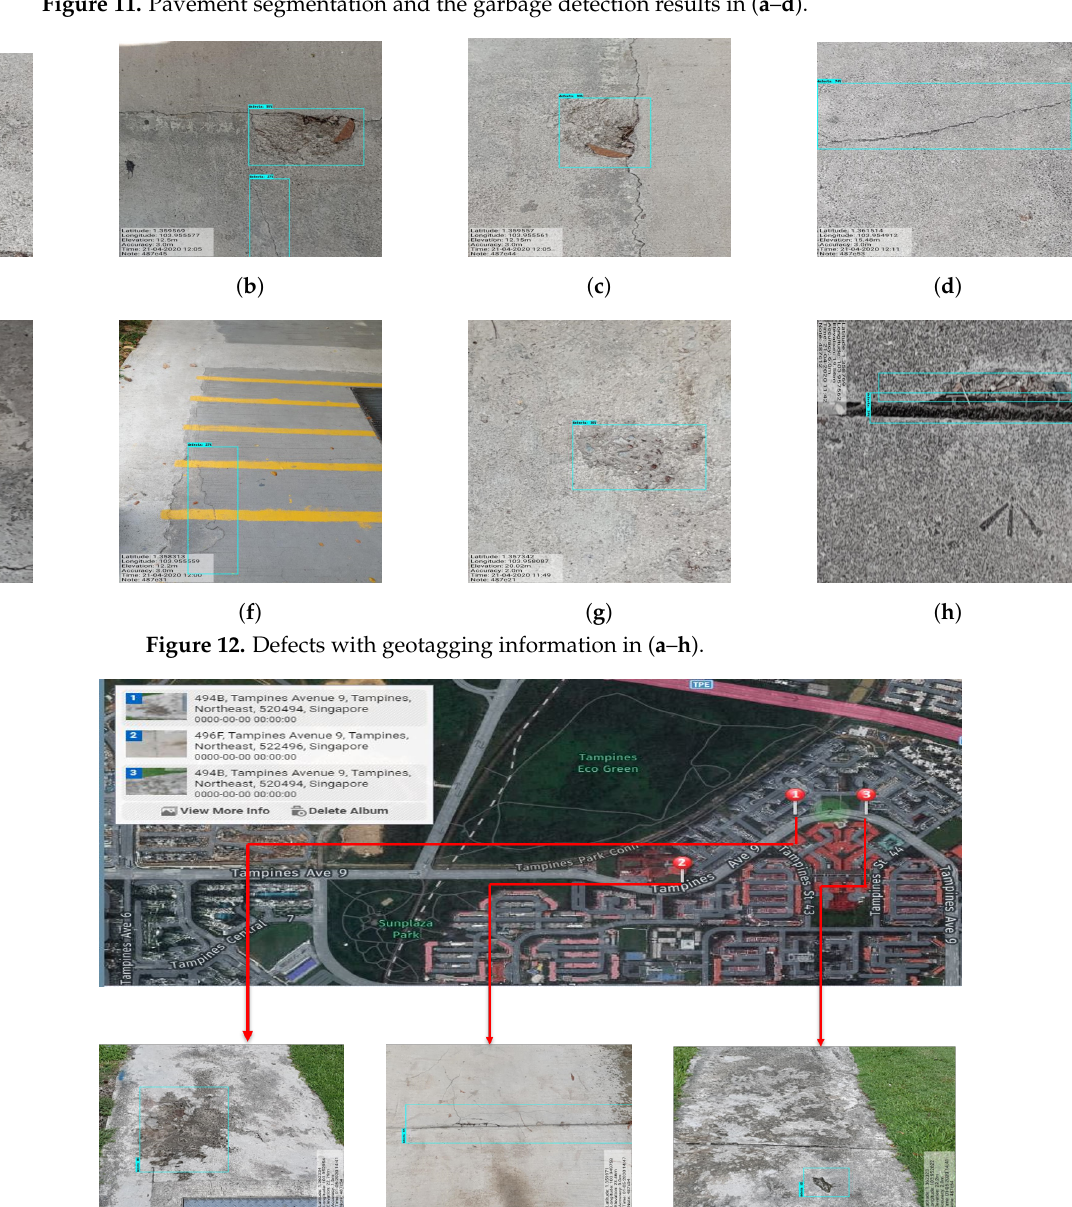
Figure 13. Defect location mapped on Google